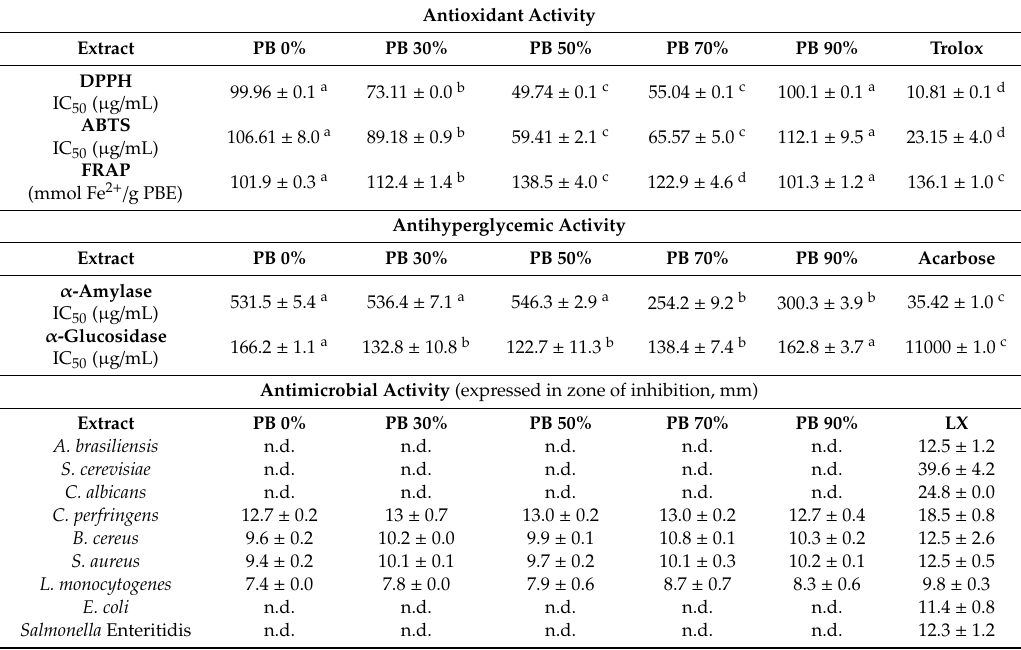
Table 4. Antioxidant (DPPH, ABTS and FRAP) and antihyperglycemic ( α -Amylase and α -Glucosidase) and antimicrobial activities of aqueous and hydroethanolic extracts from Pinus pinaster bark. Antioxidant